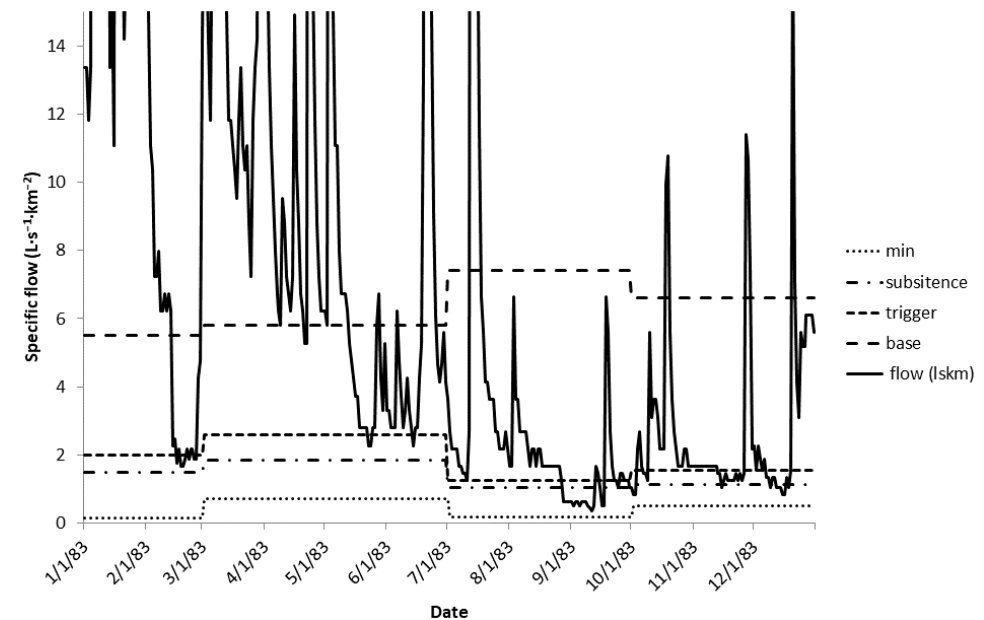
Figure 9. Flows recorded at the gauge of the Skawa River in 1983 together with flow thresholds.